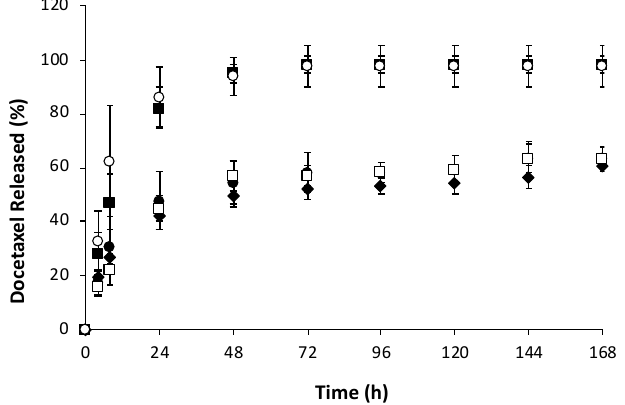
Figure 4. Docetaxel release profile from docetaxel-loaded PHB70 nanoparticles produced with different drug/polymer ratios: 5 (l), 10 (¿), 20 (£), 30 (¢) and 40% (¡) ( n = 3, mean ± SD)